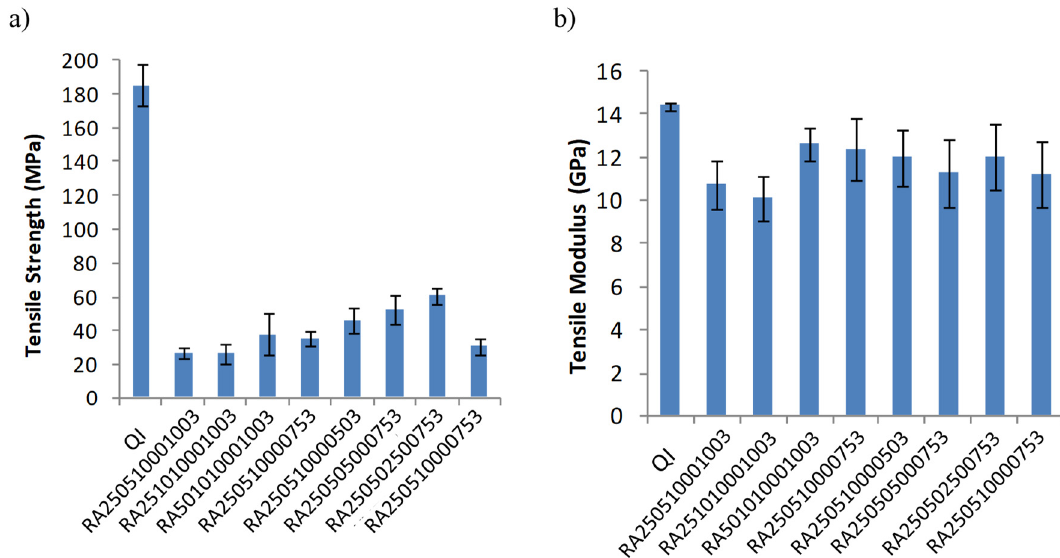
Figure 10. Tensile properties the composite specimens: ( a ) strength, ( b ) modulus .